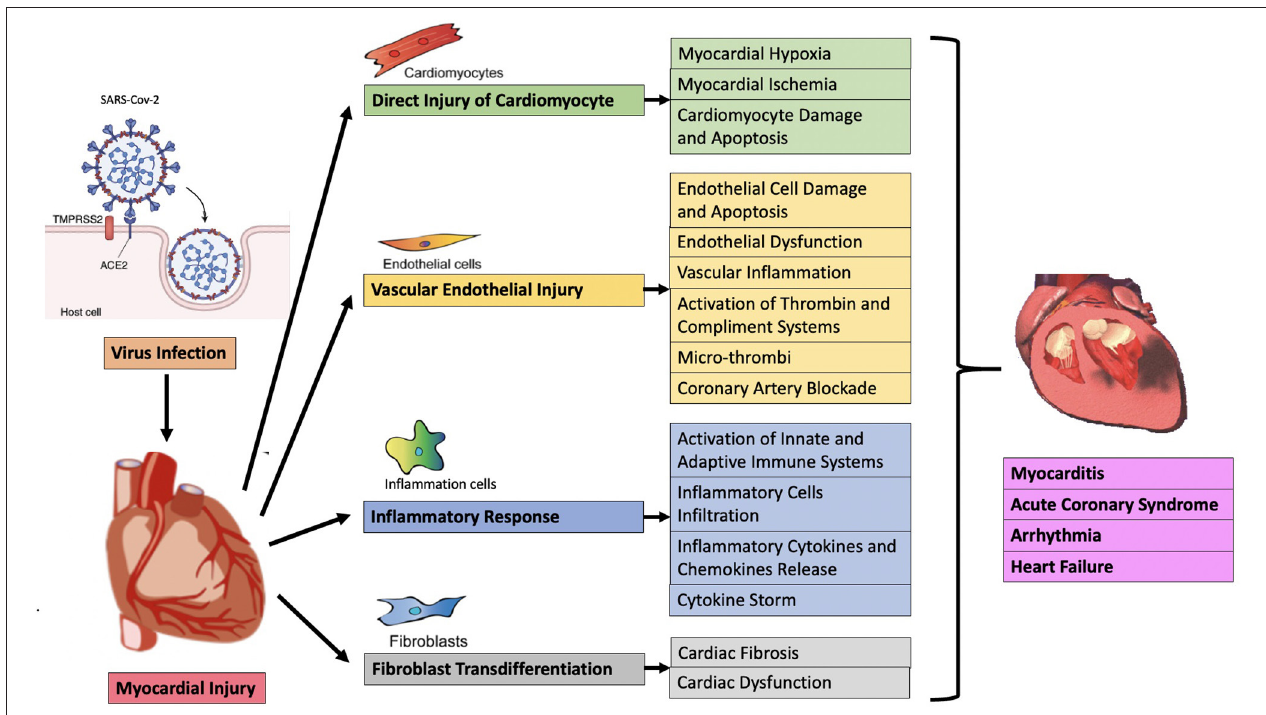
FIGURE 1 | Possible pathological mechanism of acute myocardial injury in COVID-19.